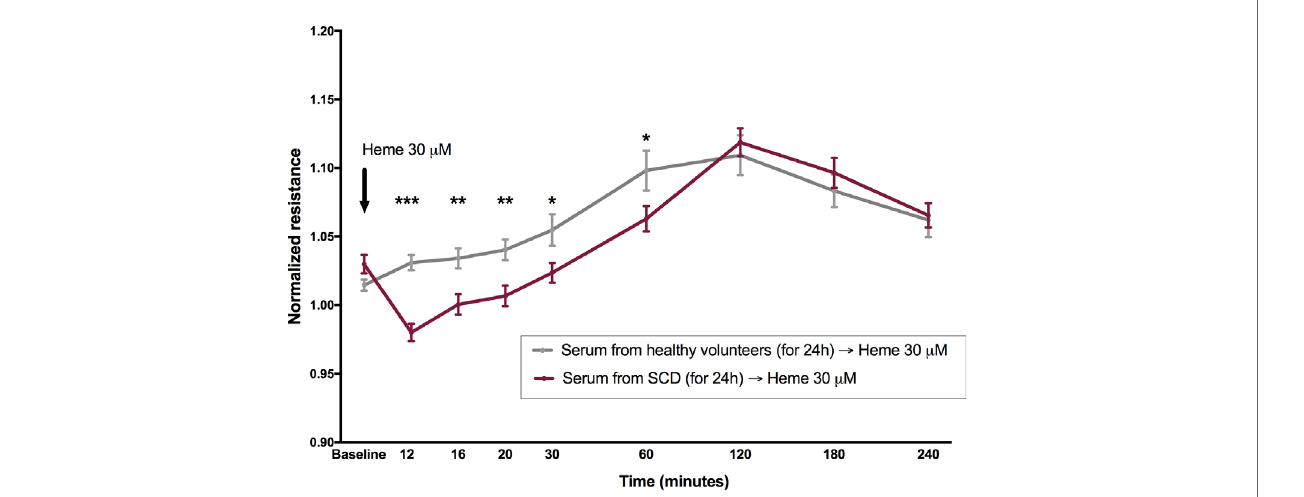
FIGURE 3 | Heme is capable to induce EB disruption in the presence of serum from patients with SCD, but not from healthy volunteers. Con fl uent HUVEC monolayers were incubated with sera (20% v/v) from SCD patients (n = 20) or healthy volunteers (n = 10) for 24 h, followed by challenge with heme 30 µM (black arrow). Normalized resistance was recorded at 4,000 Hz. Each line represents the mean ± SEM in the speci fi ed time points. Differences were compared using the Mann-Whitney test. Statistical signi fi cant differences are indicated by colored asterisks on each timepoint. *P= 0.01 to 0.05; **P<0.01; ***P<0.001. Heme was diluted in NaOH, and the fi nal NaOH concentration in heme dilutions was 0.06 µM.